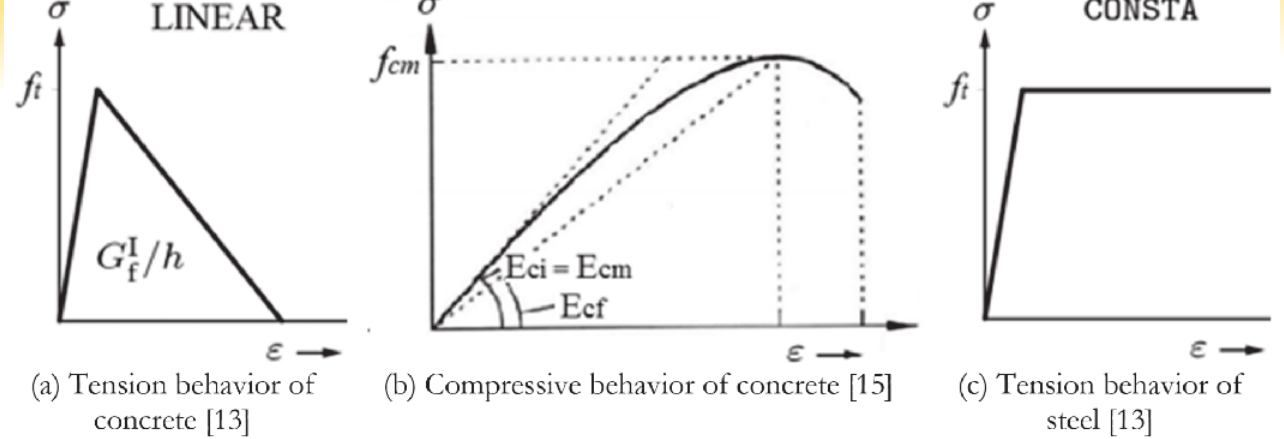
Constitutive models used in computational